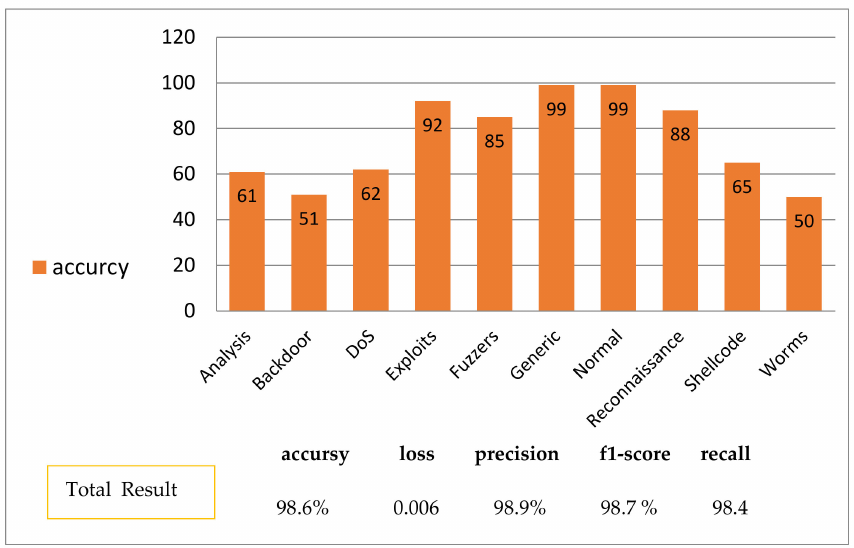
Figure 17. The Inception Time and multi-class results of the UNSW-NB15 dataset with a window size of